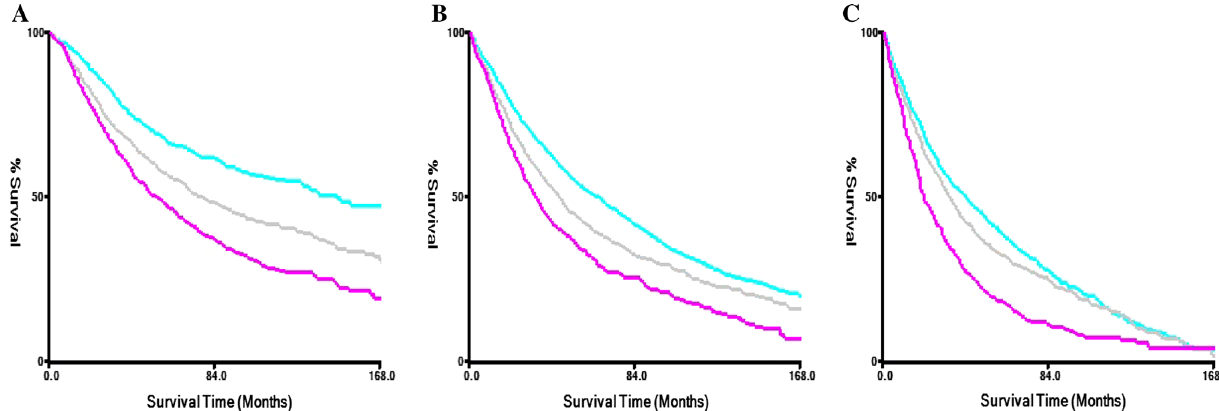
Fig. 7 Kaplan–Meier survival curves is drawn for the age subpopulation stratified by the LNR. A The stage < 60. B The stage 60–75. C The stage >